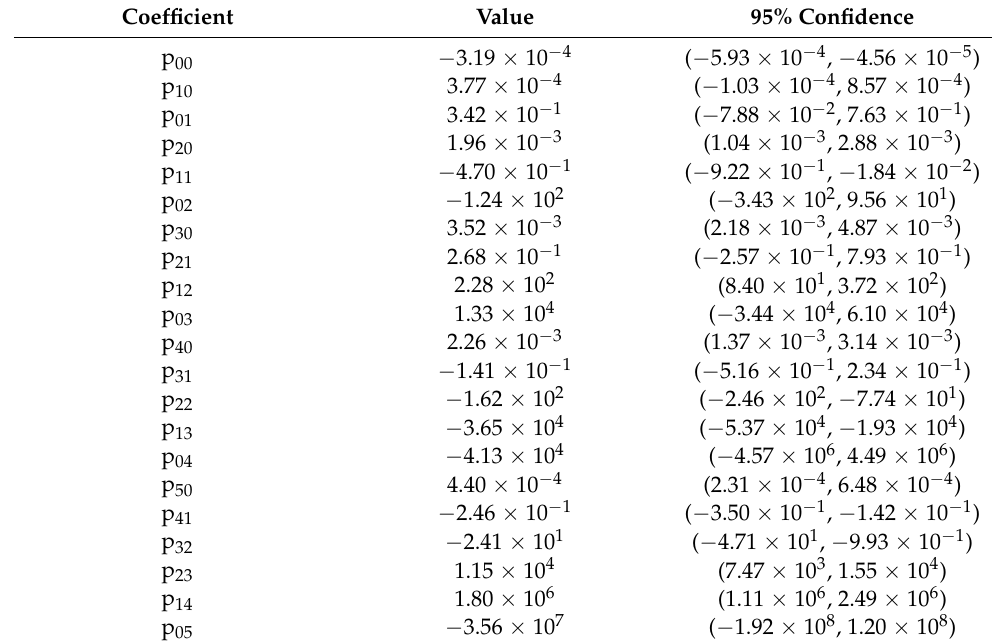
Table 1. Coefficients for the approximation of g G in Equation (15). The units for coeffient p ij are